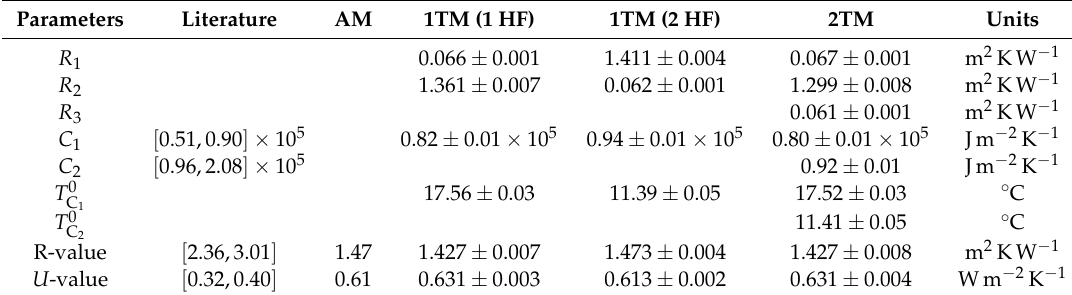
Table 2. Thermophysical properties for the CWall_N for the average (AM) and dynamic (using the 1TM (1HF), 1TM (2HF), and the 2TM models) method. Only the statistical error is shown, and the number of significant figures was chosen to illustrate the level of the